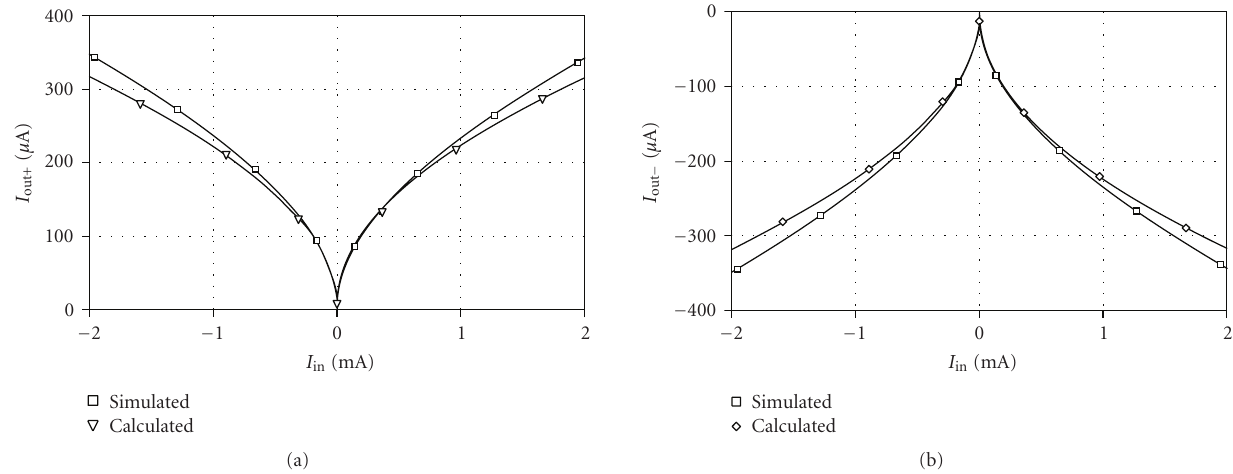
Figure 4: Simulated DC transfer characteristics of proposed square-rooting circuit: (a) positive input; (b) negative